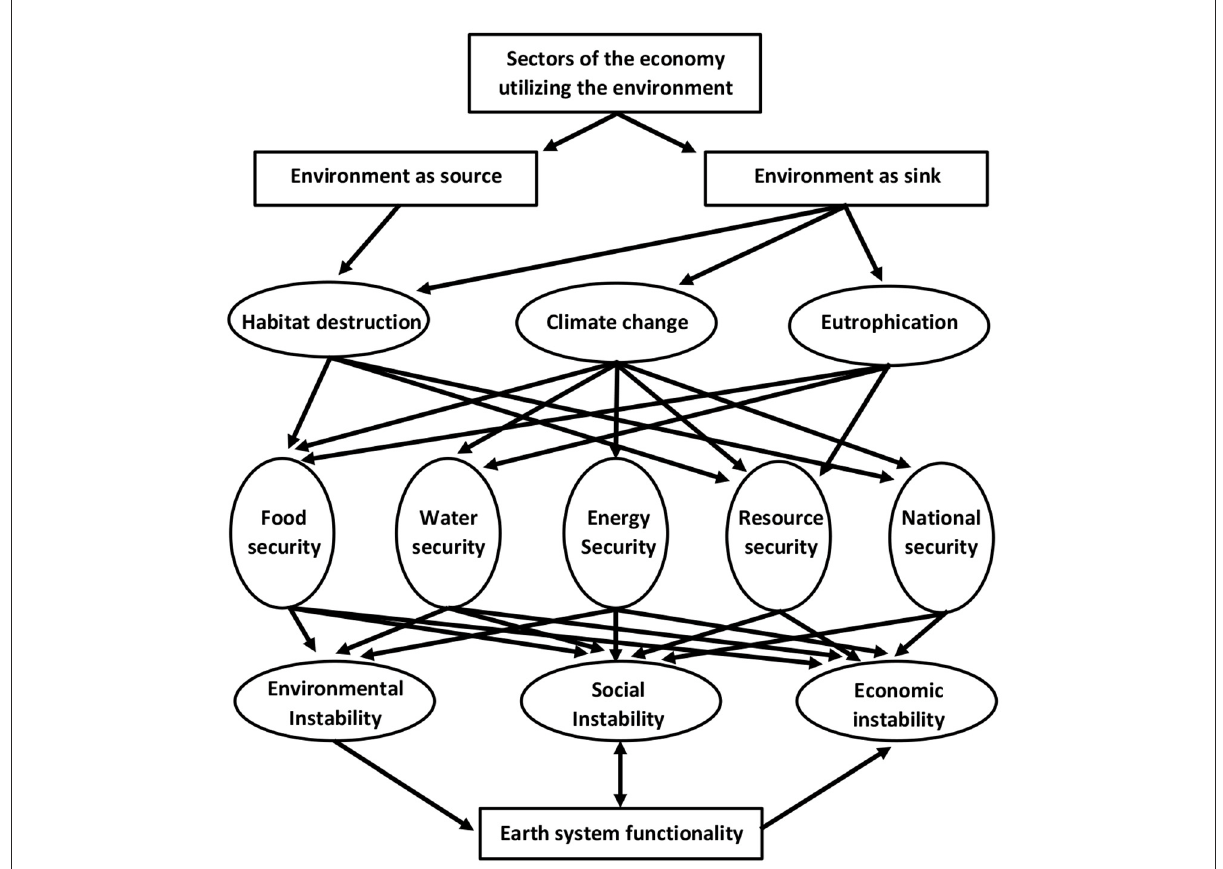
FIGURE2 The relationship between economic activity, Earth system functionality and